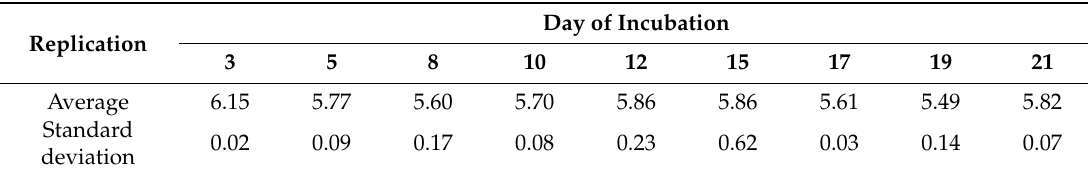
Figure 4. The content of methane in the biogas on successive days of incubation at 2% loading in bottles with daily gas removal and in bottles without gas removal. Table 2. pH of the suspension in bioreactors (2% loading) without daily gas removal on consecutive incubation days. Results of measurement series 2.